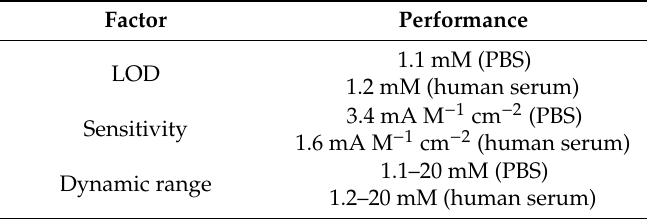
Table 3. Measures of the performance of the DSS-based urea